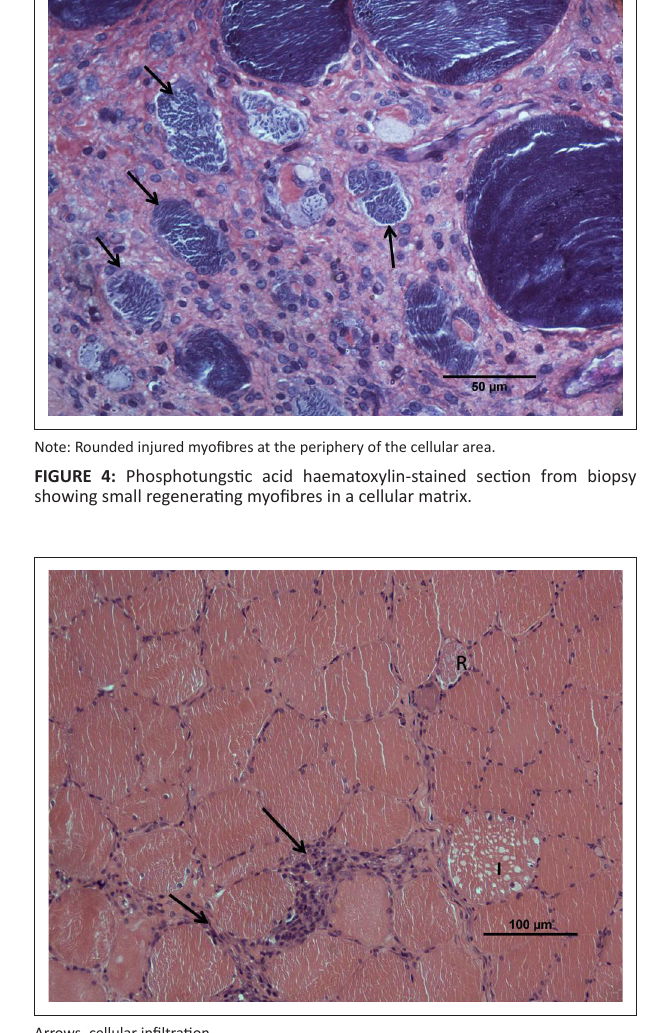
Arrows, cellular infiltration. FIGURE 5 : Haematoxylin and eosin-stained section from subdermal biopsy showing an injured myofibre (I) and possible regenerating (R) fibre within a bundle of apparently normal